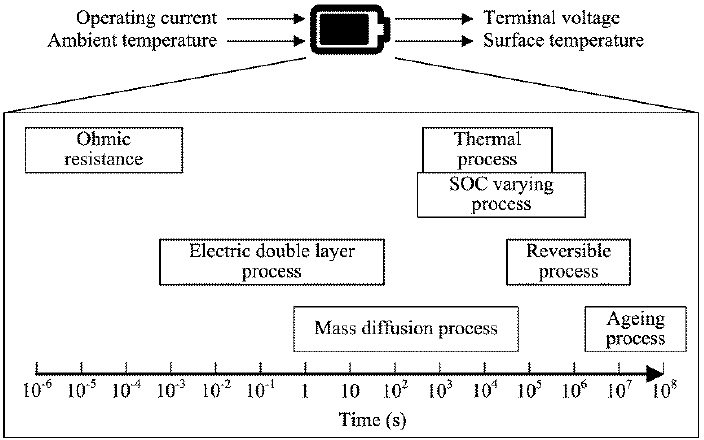
Figure 1. Systematic view of a battery.